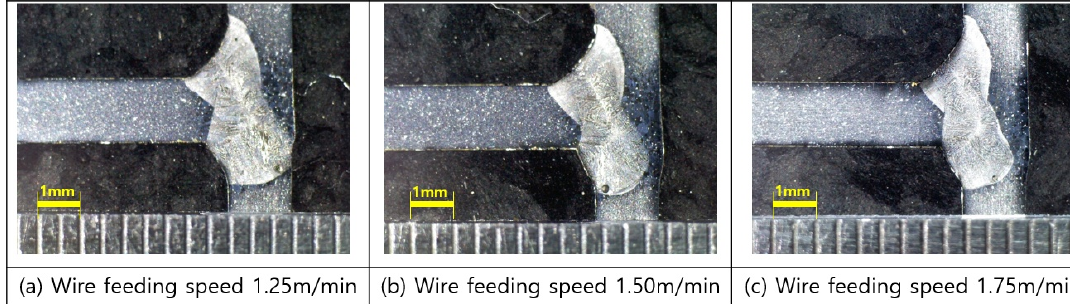
Figure 9. Di ff erent wire feeding speeds with 2.0 kW of laser power. Figure 9. Different wire feeding speeds with 2.0 kW of laser power. Figure 9. Different wire feeding speeds with 2.0 kW of laser power.